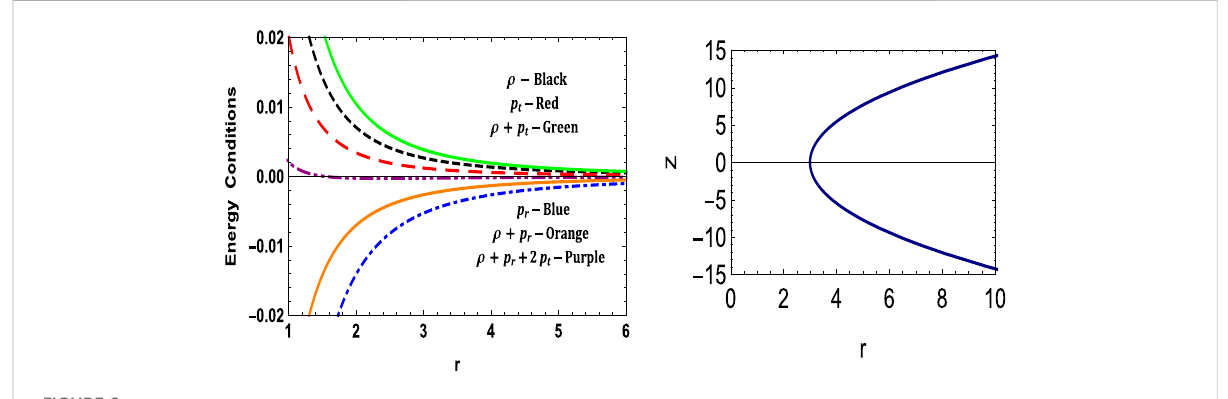
FIGURE 2 Variation of energy conditions and embedding diagram for the model I with a = 3, λ = 1.2, ω = − 2 and n =